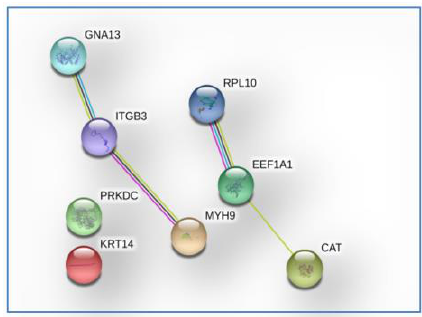
Figure 10. Protein–protein association network (medium confidence score 0.400) of the eight cancer related proteins selectively identified in grade II PF-EPs.